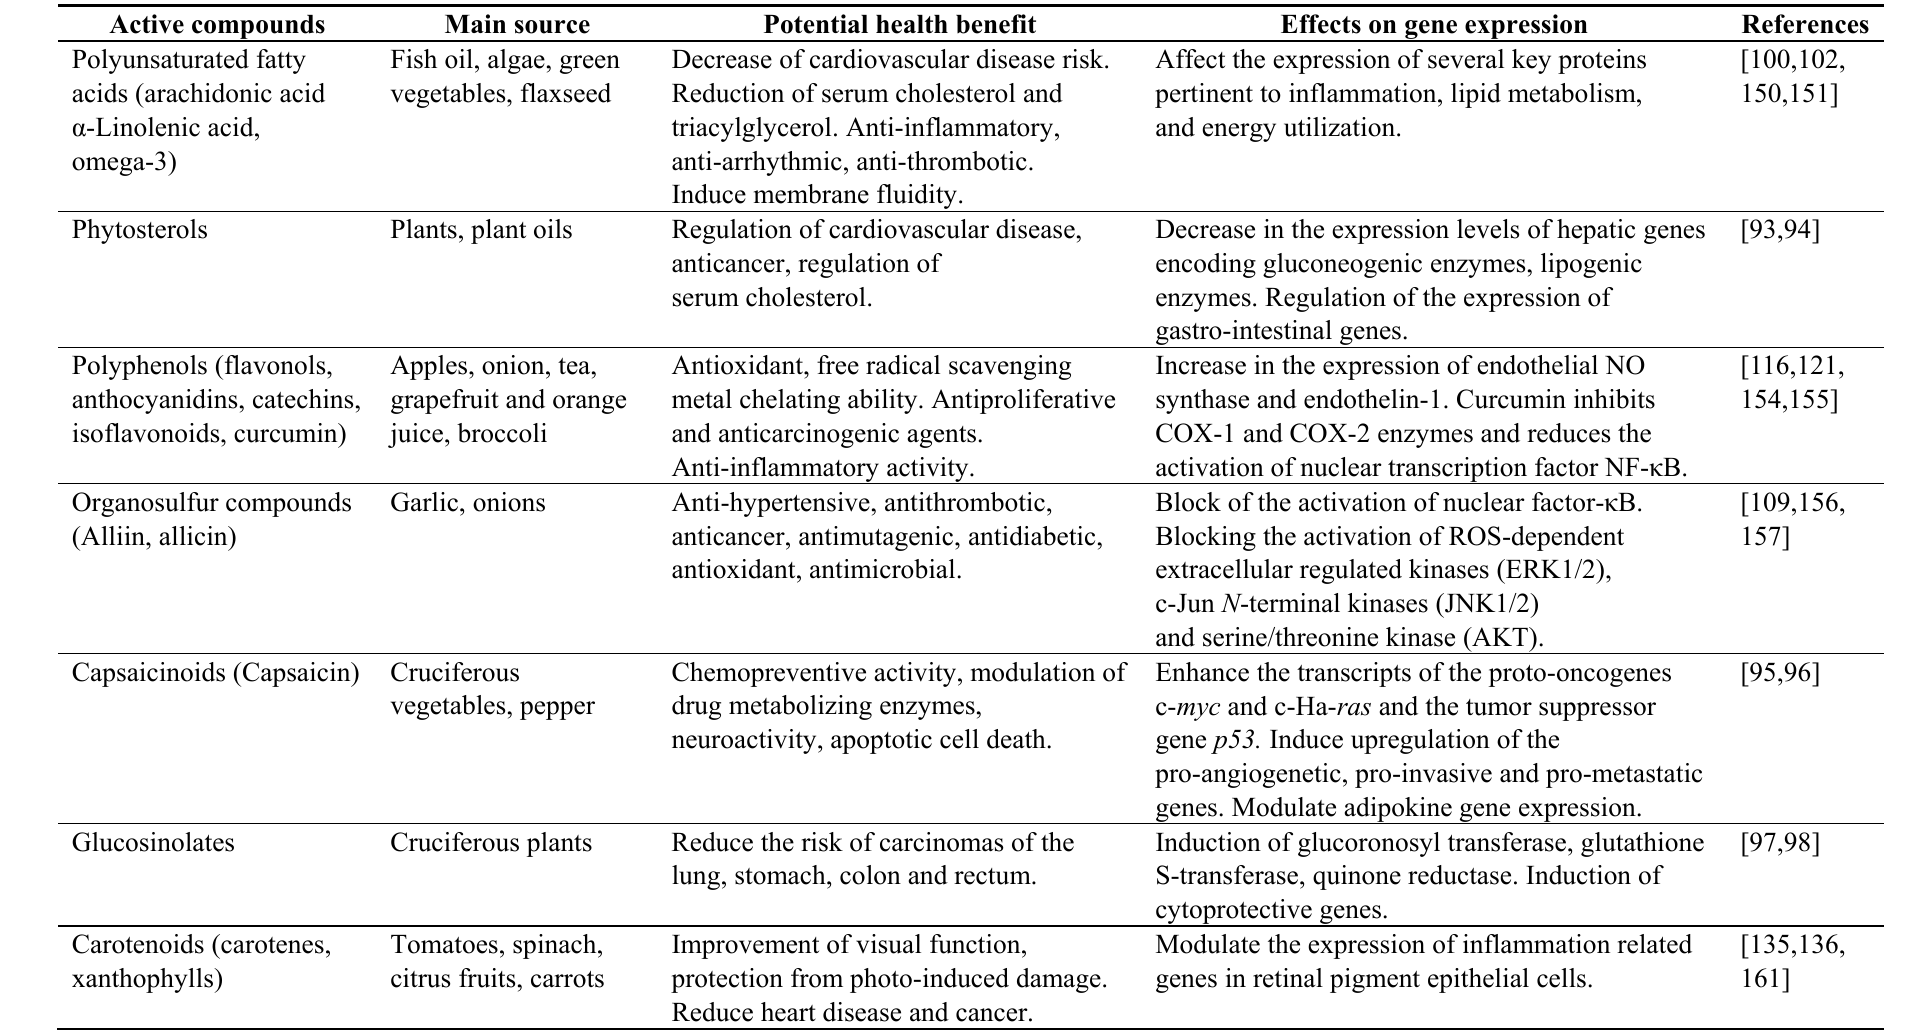
Table 1. Antioxidant effects on gene expression regulation and their preventive or potential therapeutic value in diseases induced by ionizing radiation, especially when combined with